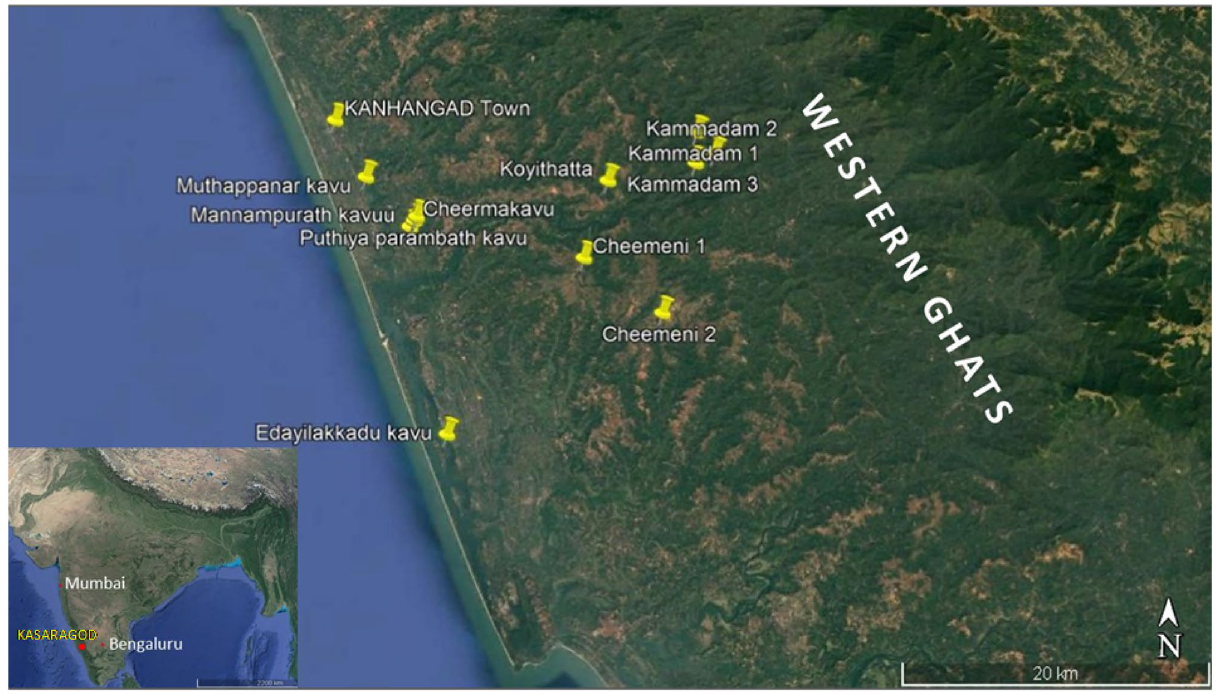
Figure 1. Google earth image of the study sites and Indian peninsula (inset). Copyright: GOOGLE EARTH